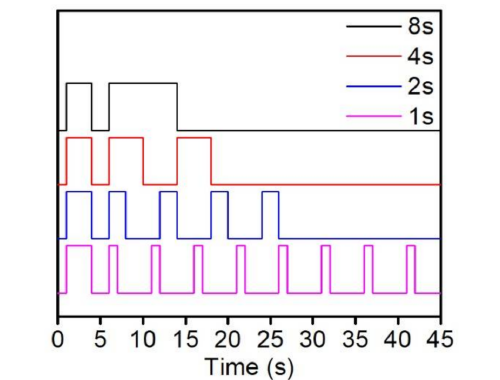
Figure 3. The curing strategies by control UV